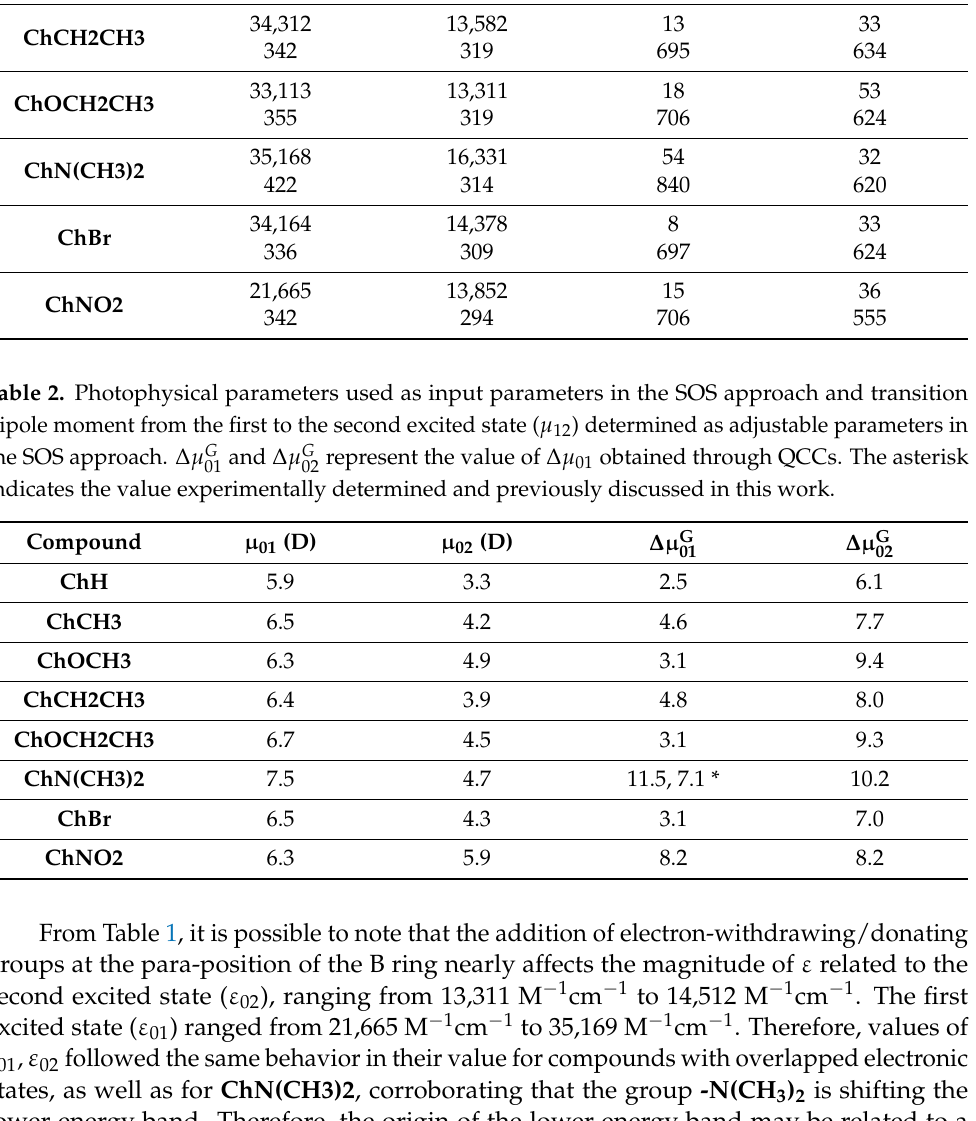
) and higher ( δ 2 PA ) energy band for S 1 S 2